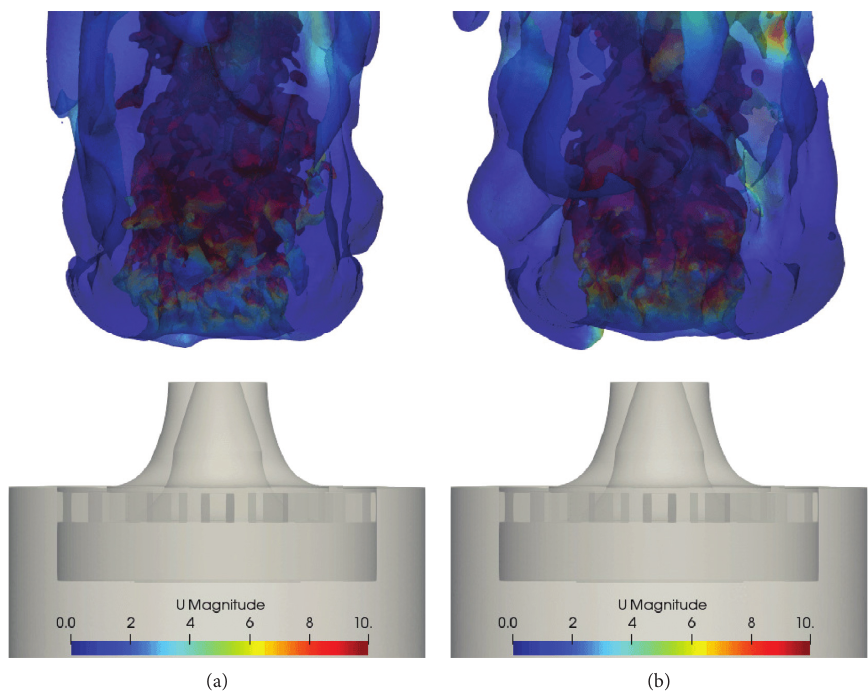
Figure 15: Contour of instantaneous temperature T (b).